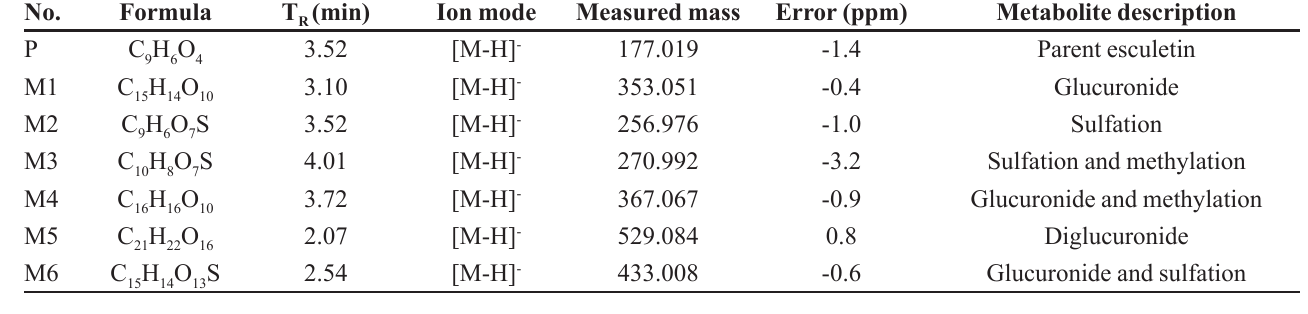
TABLE I - Accurate mass measurement of protonated metabolites in mouse serum samples in negative ion mode No.